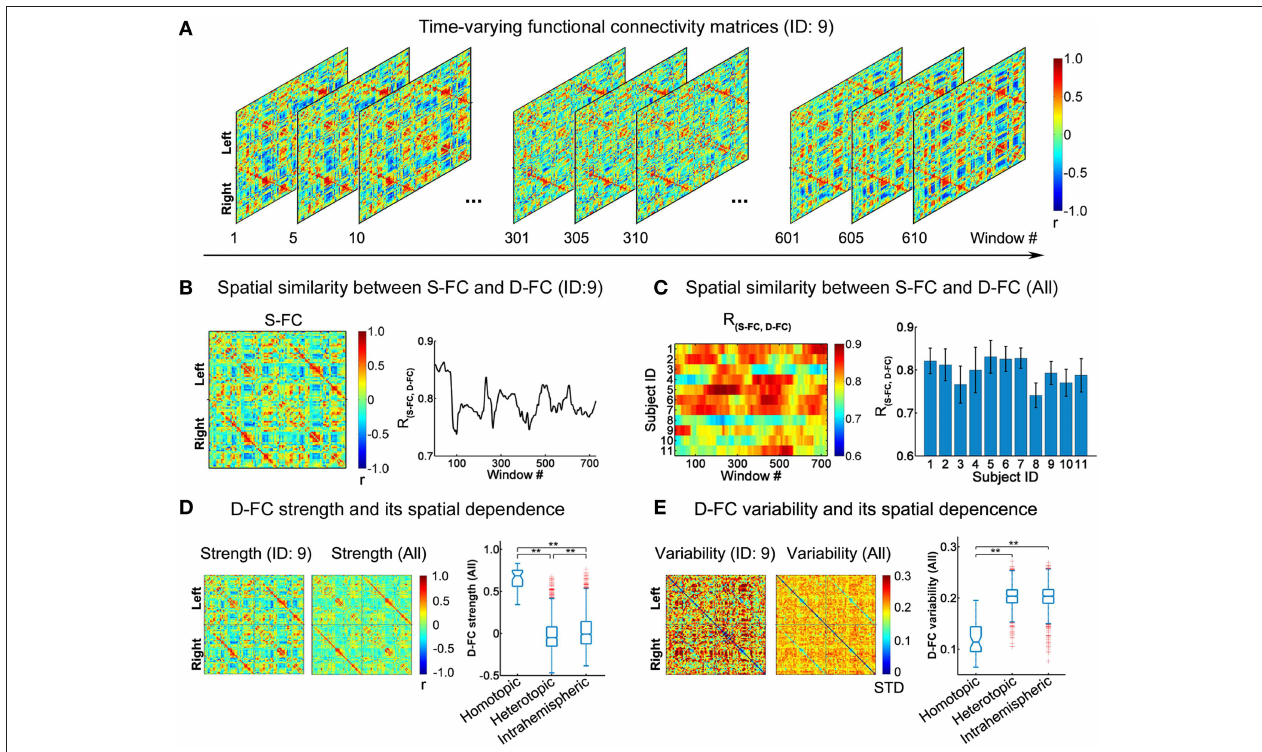
FIGURE 1 | Spatial patterns of D-FC matrices over time. (A) Transient D-FC matrices at different sliding windows for one representative participant (ID: 9). Regions of interest (ROIs) were indexed in an order of left (ROIs: 1-45) to right (ROIs: 46-90) hemisphere (for details of the ROIs, see Table S2). (B) Static functional connectivity (S-FC) matrix of the same participant (ID: 9) (left) and its spatial similarity with the D-FC matrices over time (right). R ( S − FC , D − FC ) denotes the spatial similarity between the S-FC and the D-FC matrices obtained using Pearson’s correlation analysis following Fisher’s r-to-z transformation. (C) Time-varying spatial similarity between the S-FC and the D-FC matrices for all participants (left) and associated temporal mean and temporal variability across windows (right). Error bars represent the standard deviation across windows. (D) D-FC strength and its spatial dependence for one participant (ID: 9) and for all participants. (E) D-FC variability and its spatial dependence for one participant (ID: 9) and for all participants. In (D, E) , the D-FC strength/variability matrix for all participants was generated by averaging the individual strength/variability matrices across participants. The statistical difference between any two categories of D-FC was tested using permutation tests (**Bonferroni corrected p < 0 . 001 , 10,000 permutations). S-FC, static functional connectivity; D-FC, dynamic functional connectivity.